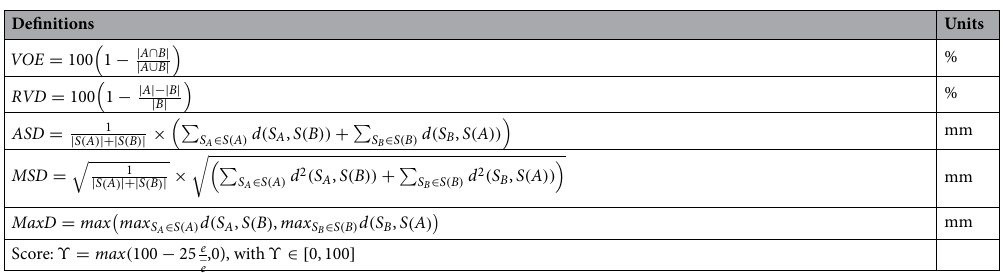
Table 3. The definitions of five evaluation